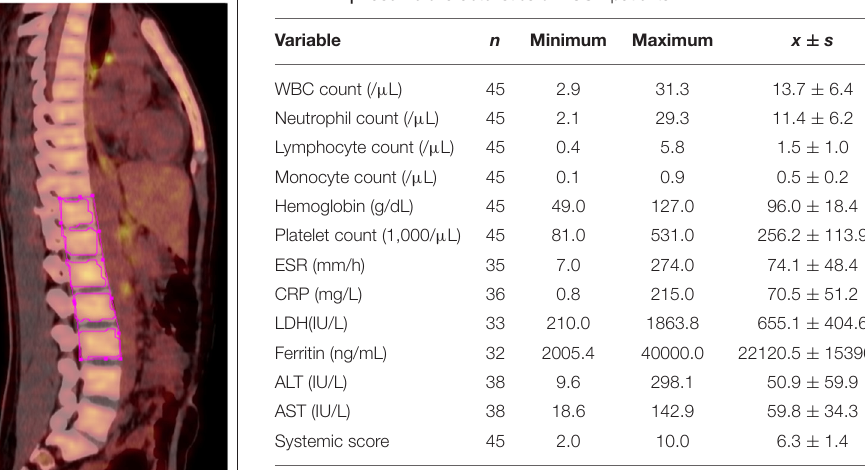
TABLE 1 | Baseline characteristics of AOSD